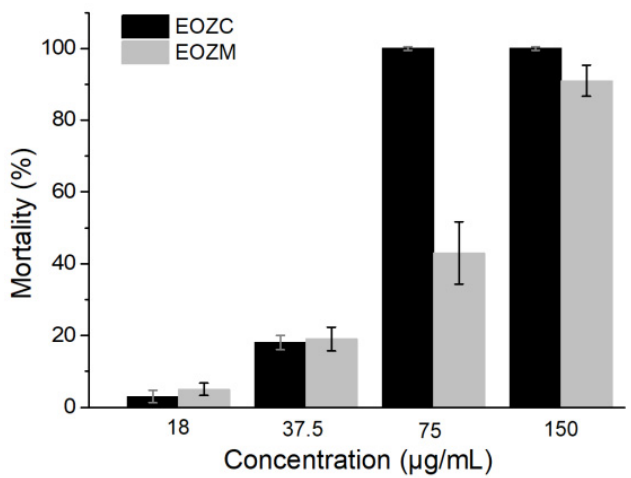
Figure 3. Larvicidal activity of essential oils from Z. acanthopodium fruits.